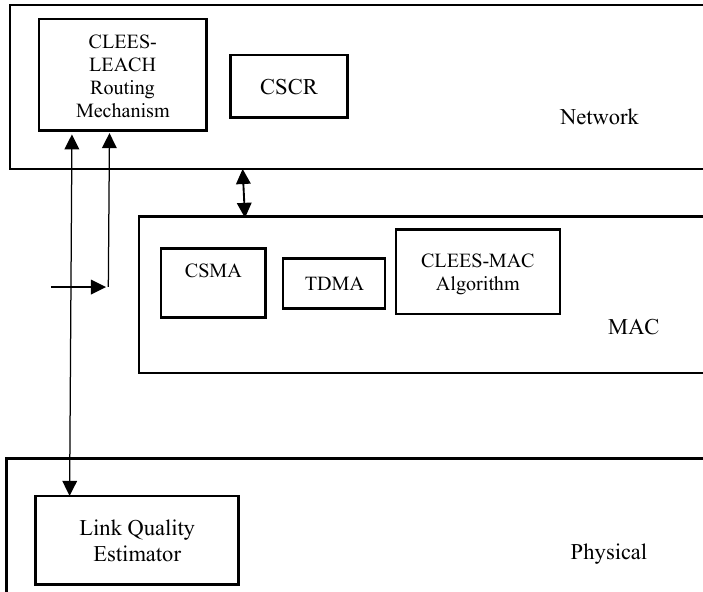
Figure 1. Cross Layer